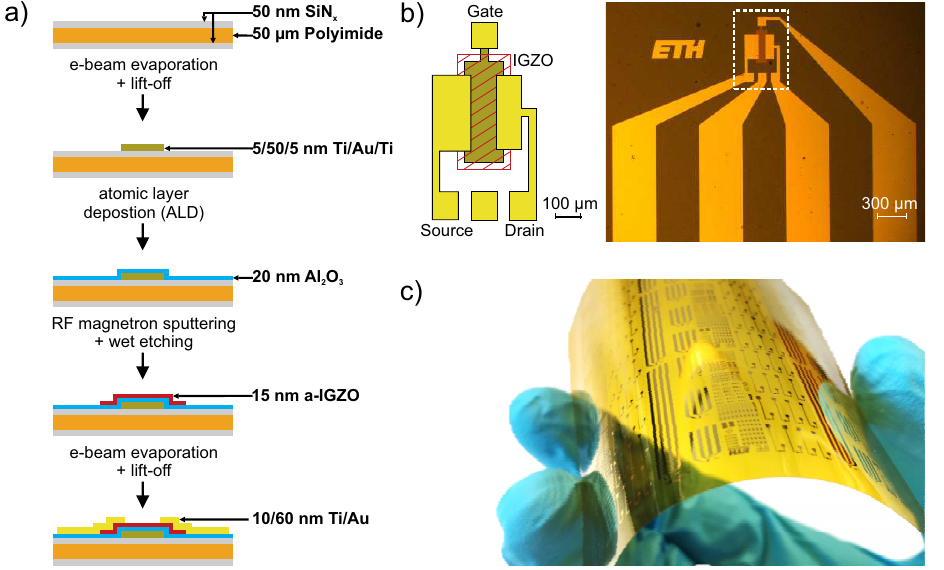
Figure 1. ( a ) schematic fabrication flow of the gas sensitive thin-film transistor (TFT) including the respective layer thicknesses. ( b ) layout of the TFT indicating the different layers and dimensions ( left ) and a macroscopic picture of the fabricated device ( right ). The TFT is highlighted with dashed lines. ( c ) photograph of the fabricated sensors on the flexible polyimide